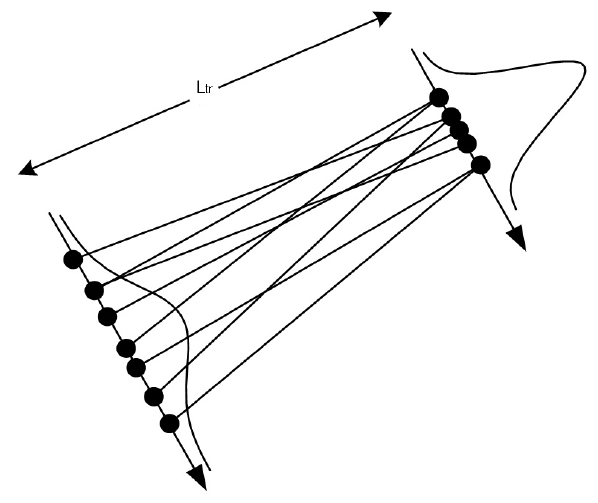
Figure 1. Influence of the distribution of initial and final points of the ship’s route.